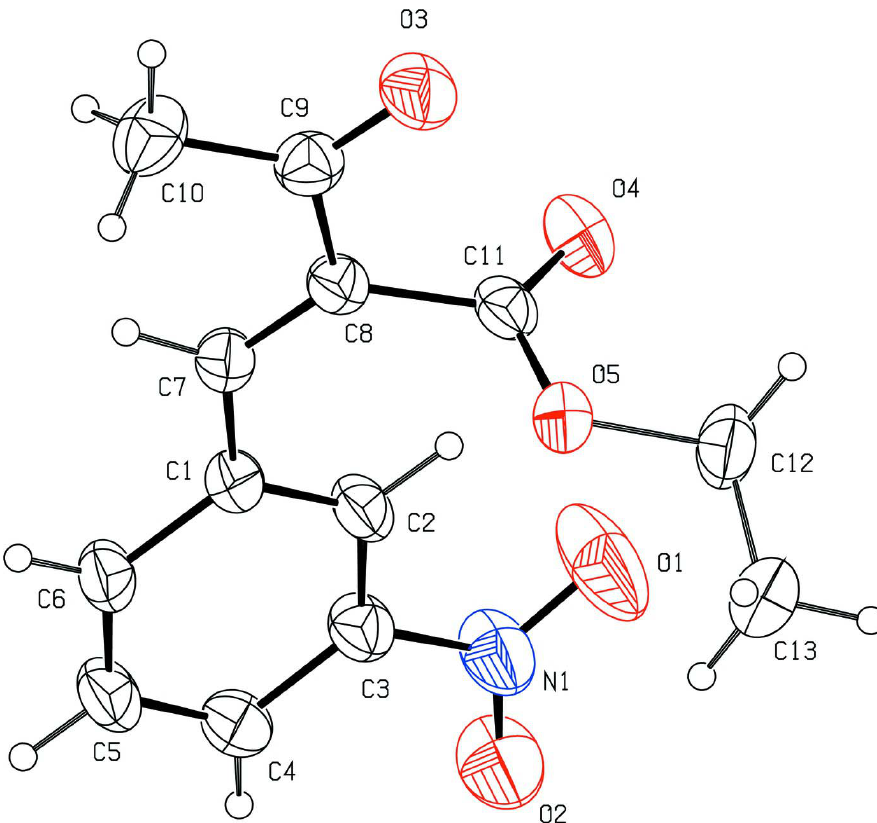
View of the title molecule showing the atom-labelling scheme. The displacement ellipsoids are drawn at the 30% probability level. Only major parts of disordered atoms are